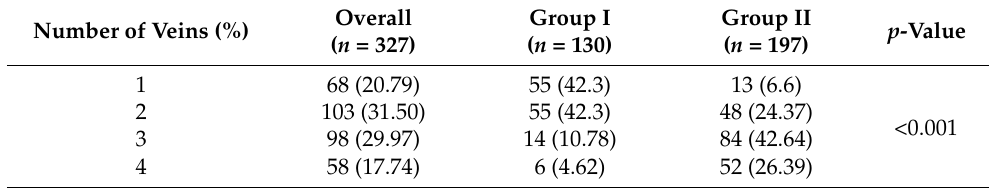
Table 2. Number of veins between MOCA (Group I) and combined EVLA and MOCA (Group II). Overall Number of Veins (%)